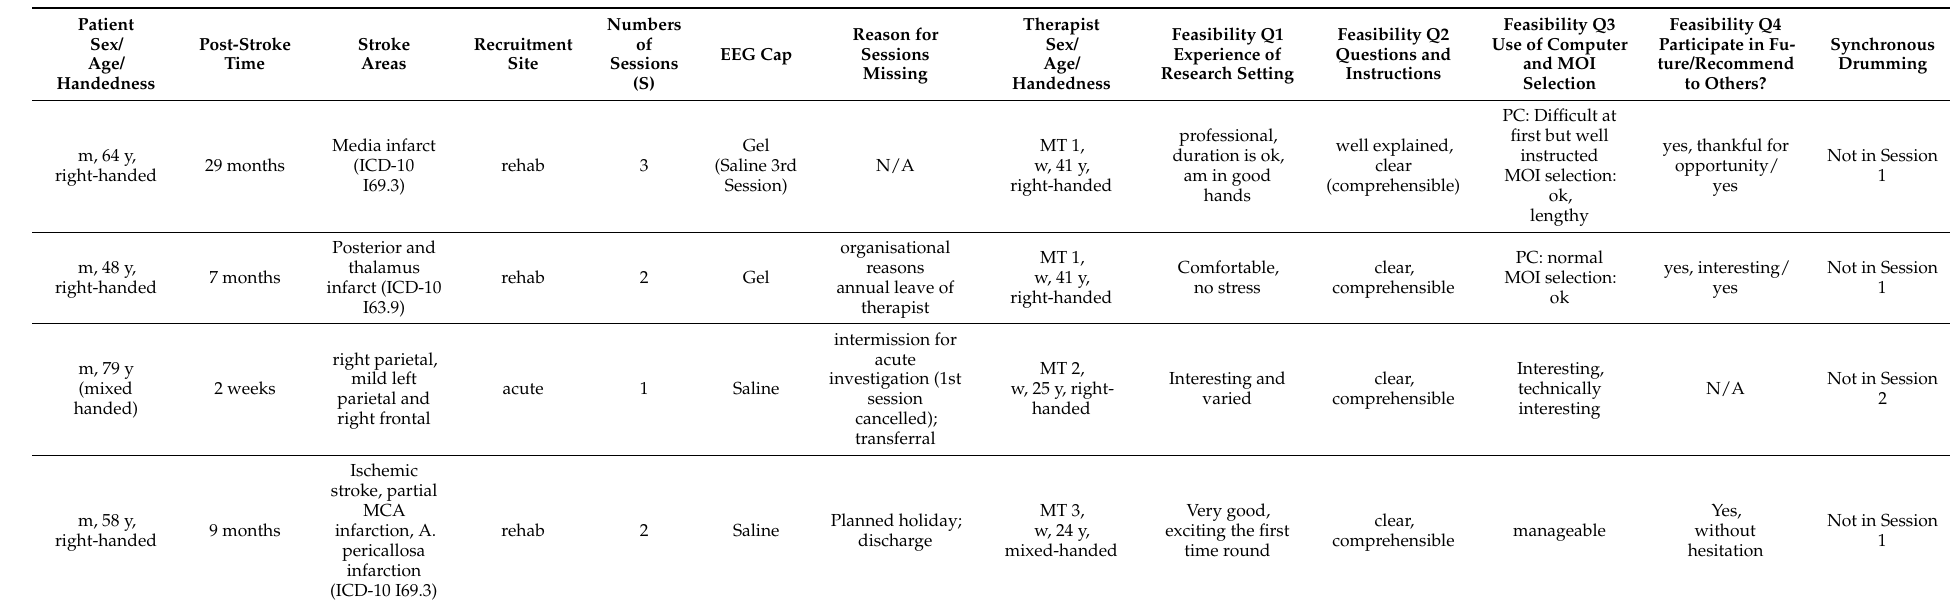
Table 2. Patient/therapist characteristics, technology used, retention and